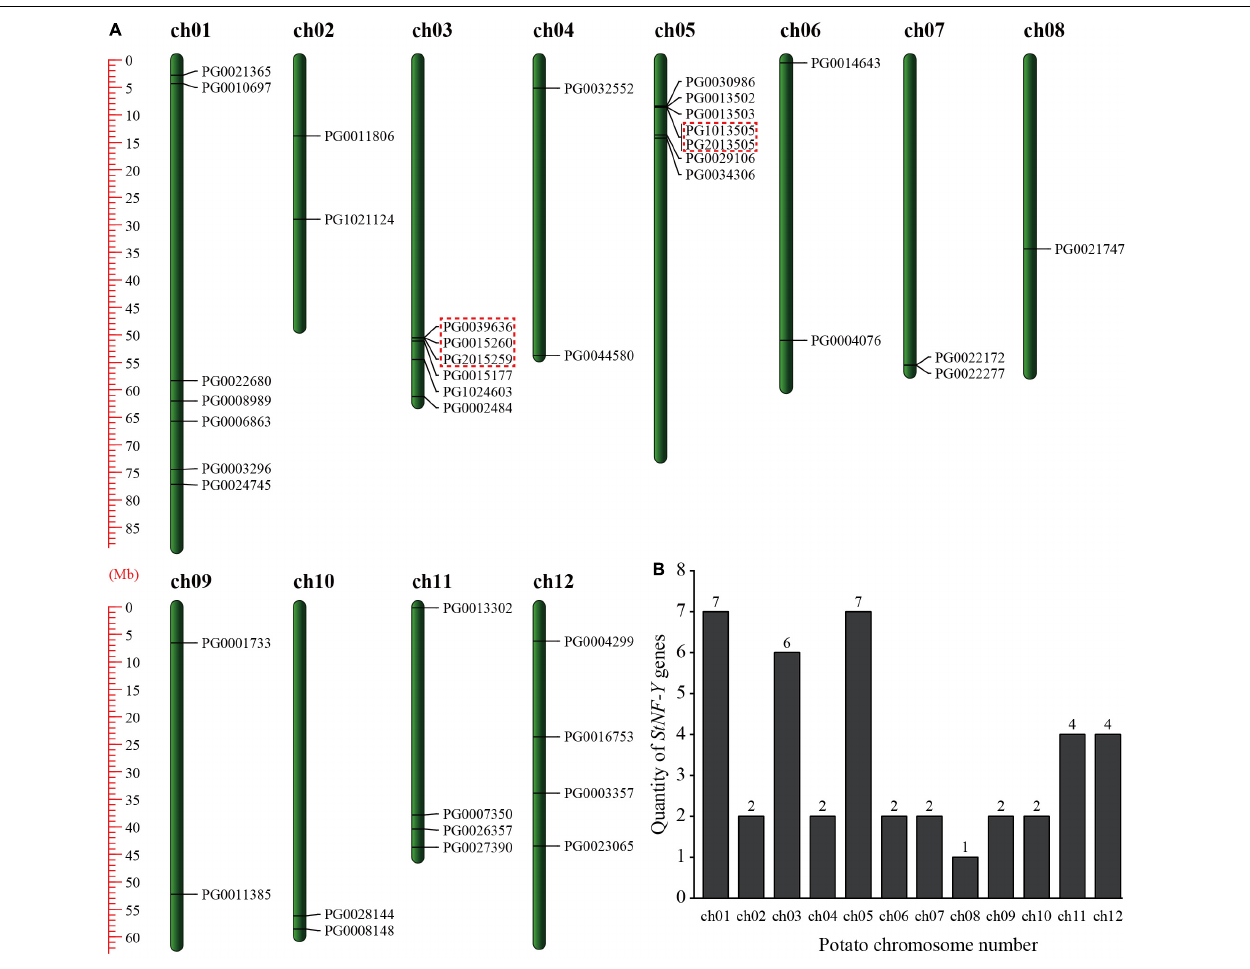
FIGURE 2 | Genomic distributions of 41 StNF-Y genes on 12 potato chromosomes. (A) “ StNF-Y gene distribution map” on 12 potato chromosomes. Tandemly duplicated genes were marked by red boxes. (B) Numbers of StNF-Y genes on each chromosome in